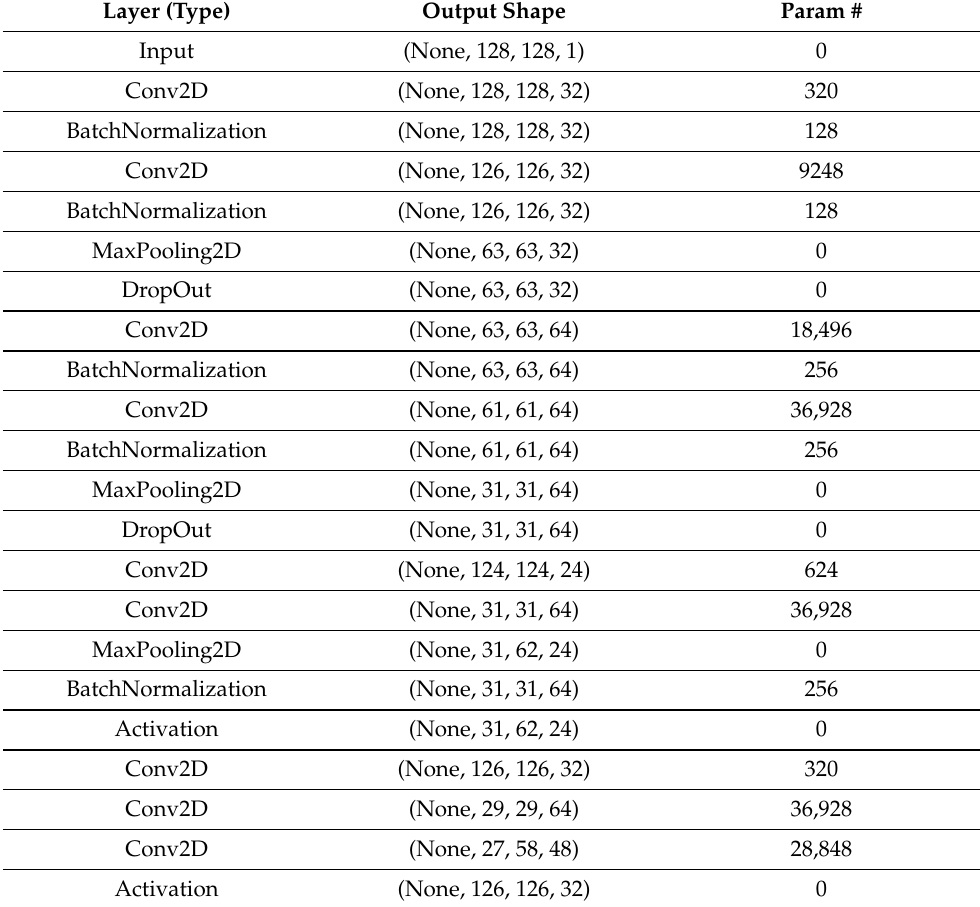
Figure 4. Overall FDC-FS Architecture Composed of FDC-1, FDC-2, and FDC-3. Table 5. FDC-FS Model